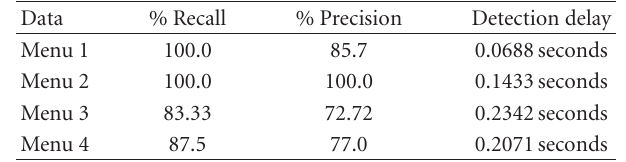
Table 3: Dancer 1 segmentation results. Table 4: Dancer 2 segmentation results.